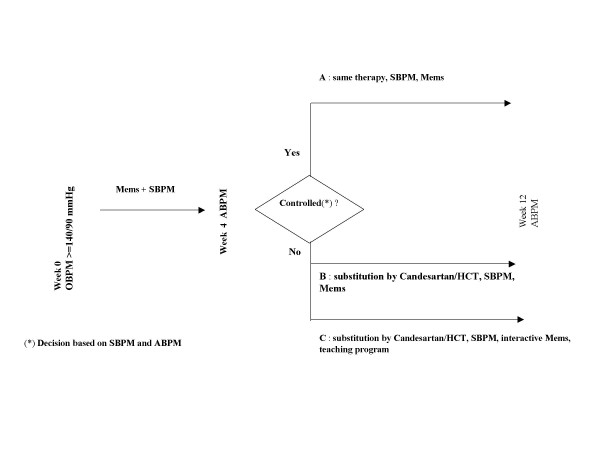
Design of the study.